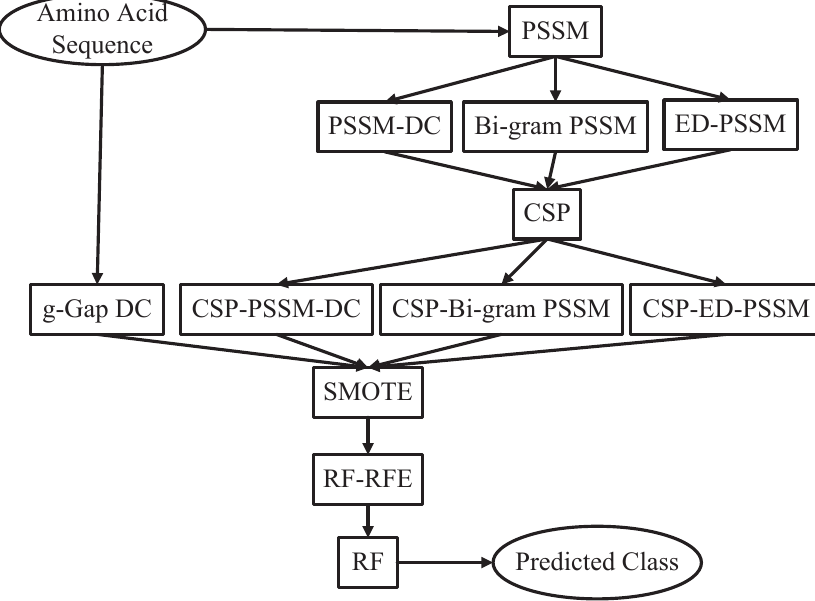
Figure 1. The system architecture of the proposed method. PSSM: Position Specific Scoring Matrix, DC: Dipeptide Composition, ED: Evolutionary Difference, CSP: Common Spatial Patterns, SMOTE: Synthetic Minority Over-sampling Technique, RF: Random Forest, RFE: Recursive Feature